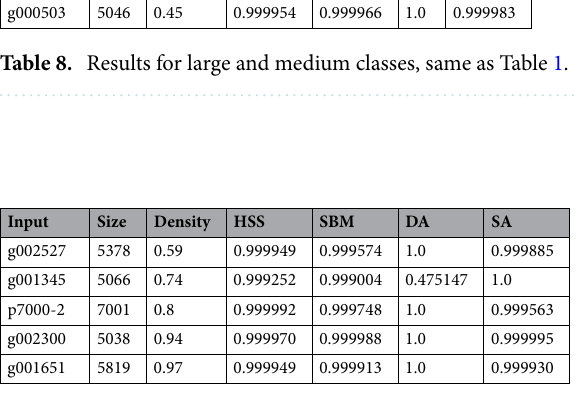
Table 9. Results for large and dense classes, same as Table